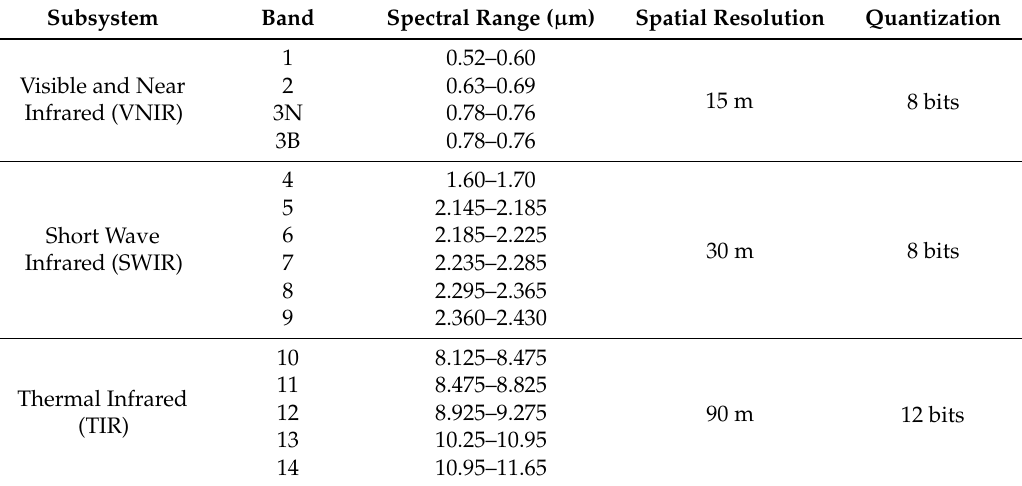
Table 1. ASTER instrument’s technical specifications.